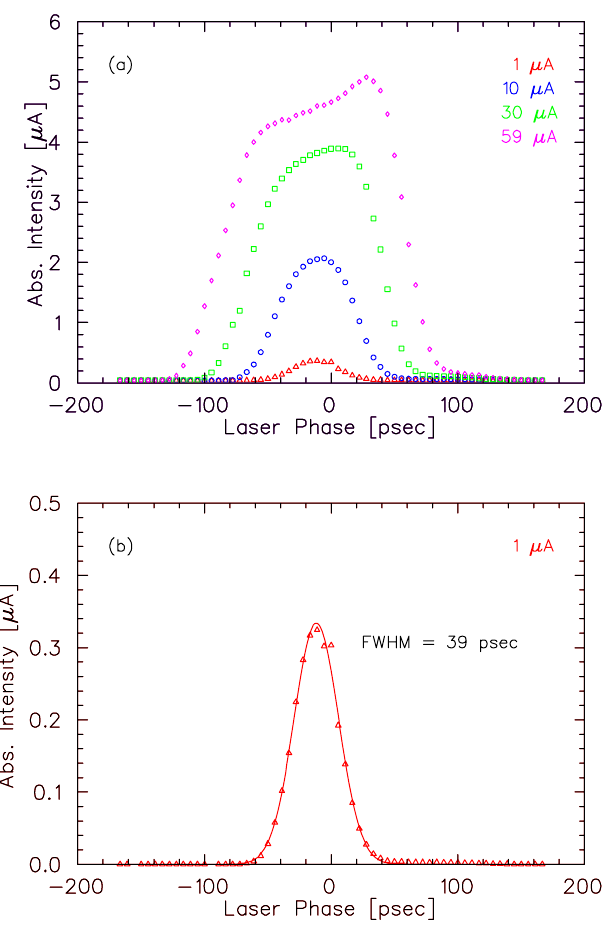
FIG. 4. (Color) (a) Electron bunchlength measurements at four different beam currents and (b) the 1 (cid:1) A data with Gaussian